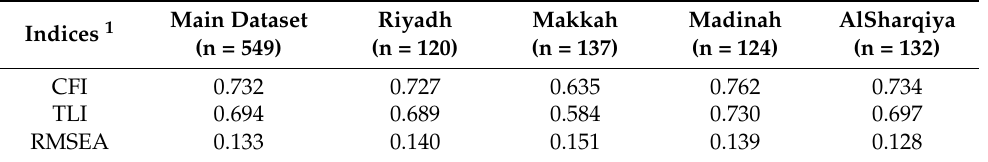
Table 2. Goodness of fit for the original four-factor model of the EDE-Q tested by CFA of main dataset and four major provinces of Saudi